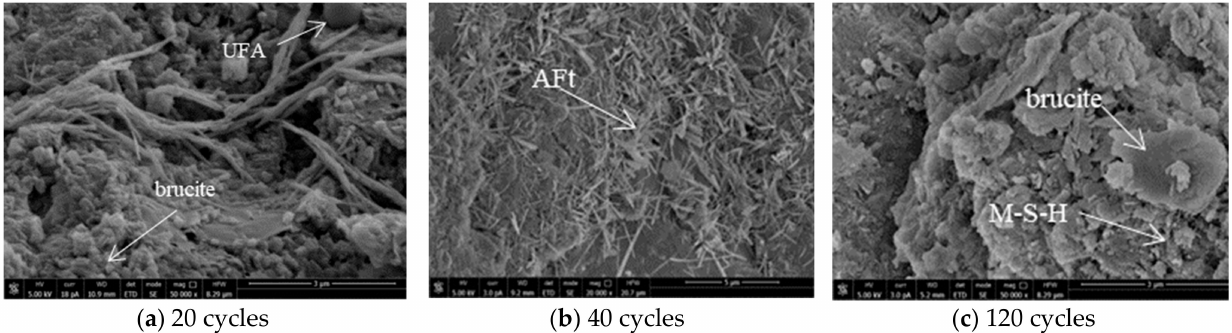
Figure 18. SEM photos of MgSO 4 solution erosion of M10F30